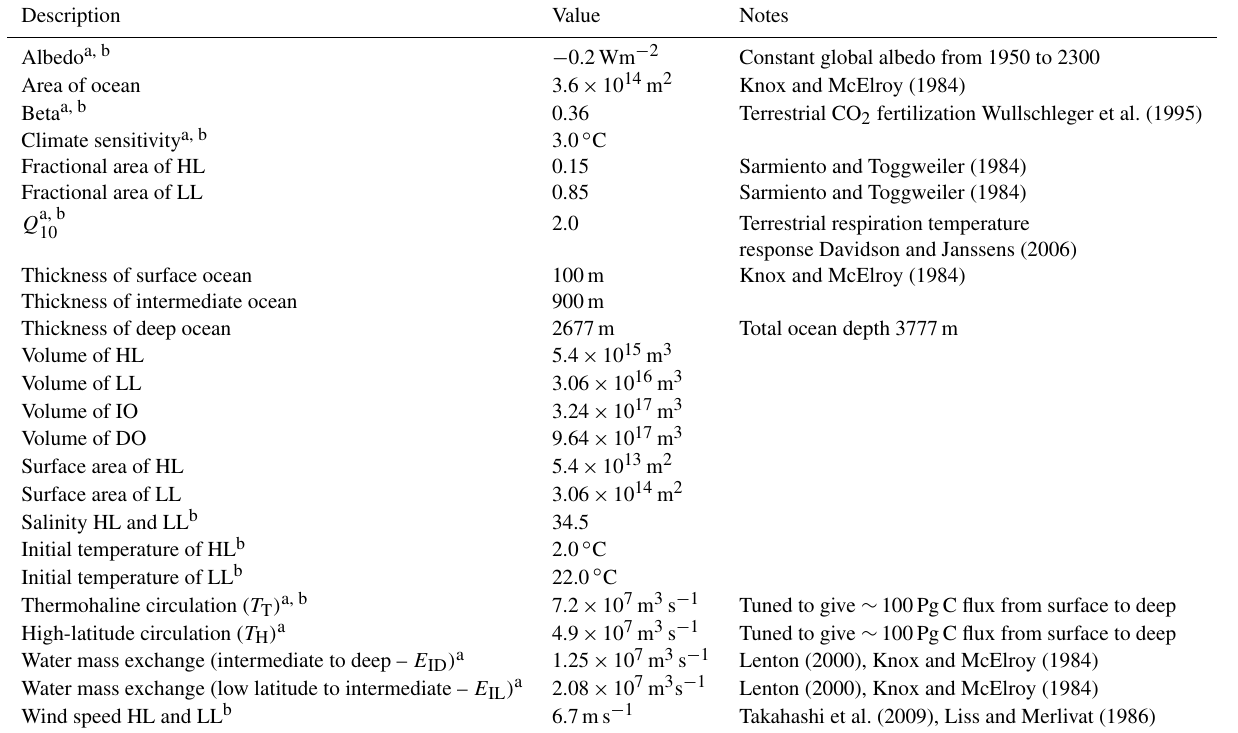
Table 1. Description and values of ocean parameters in Hector and parameters involved in the sensitivity analysis. High and low latitude are indicated as HL and